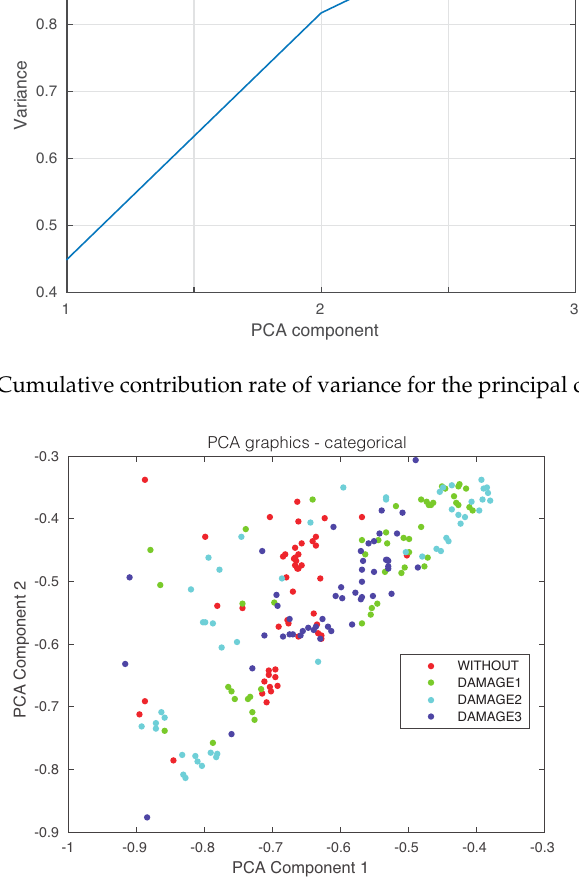
Figure 15. First principal component versus second principal component in the aluminum plate described in Section